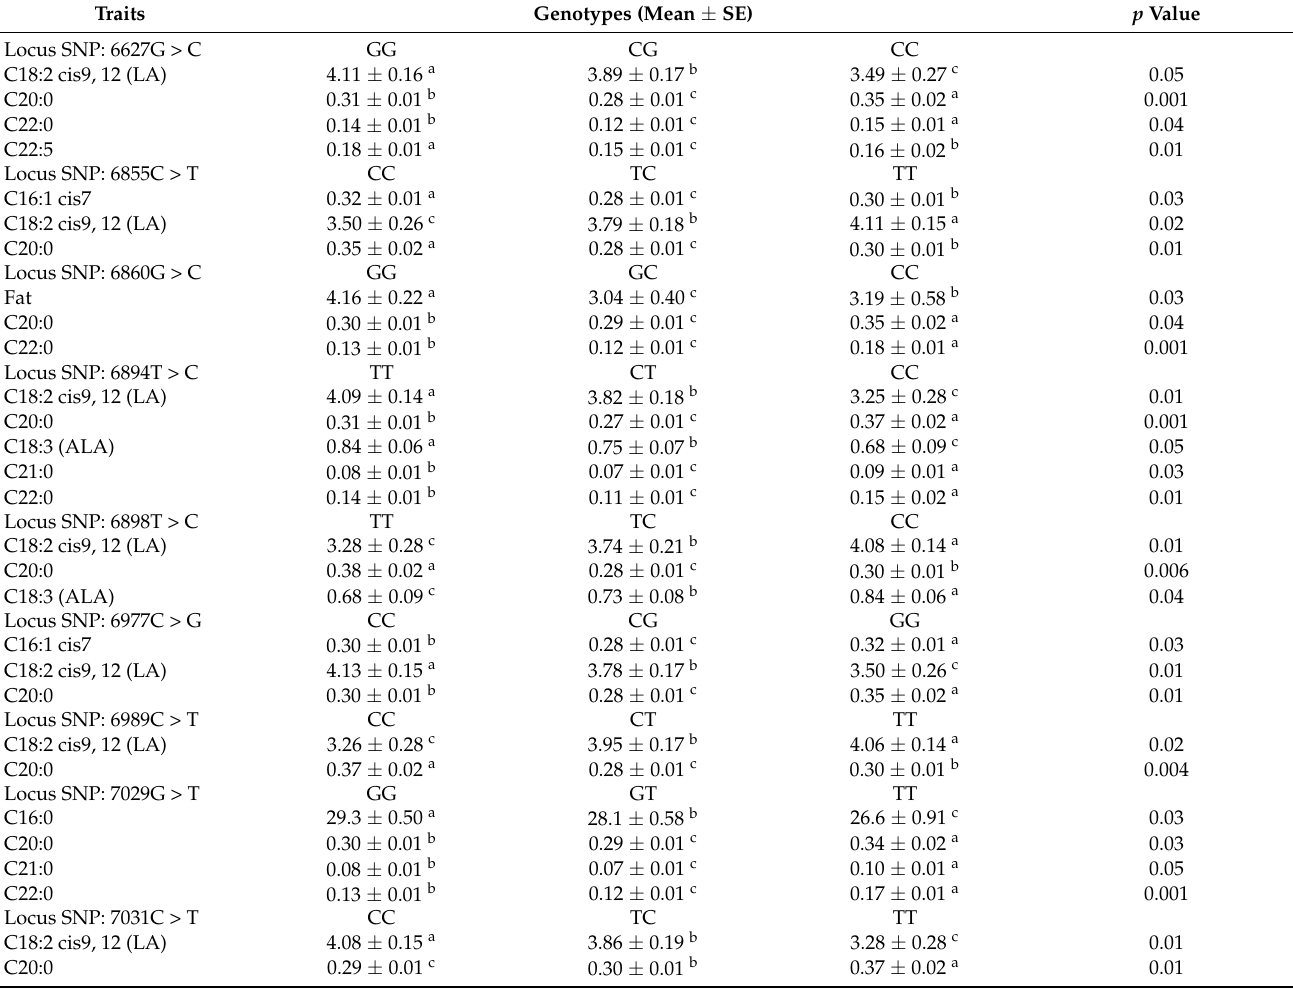
Table 6. The associations of the SNPs at Exon 53 in the ACAC α gene with the milk composition (%) and fatty acid profiles (g/100 g) in Najdi sheep